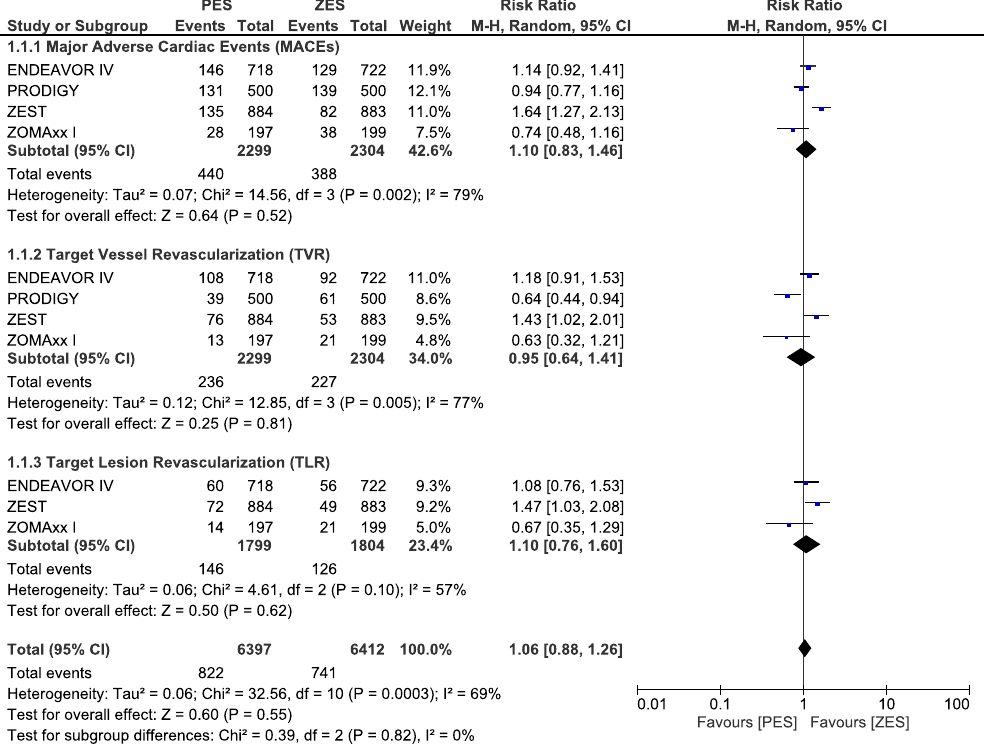
Figure 8. Long-term adverse clinical outcomes which were associated with ZES versus PES alone (part